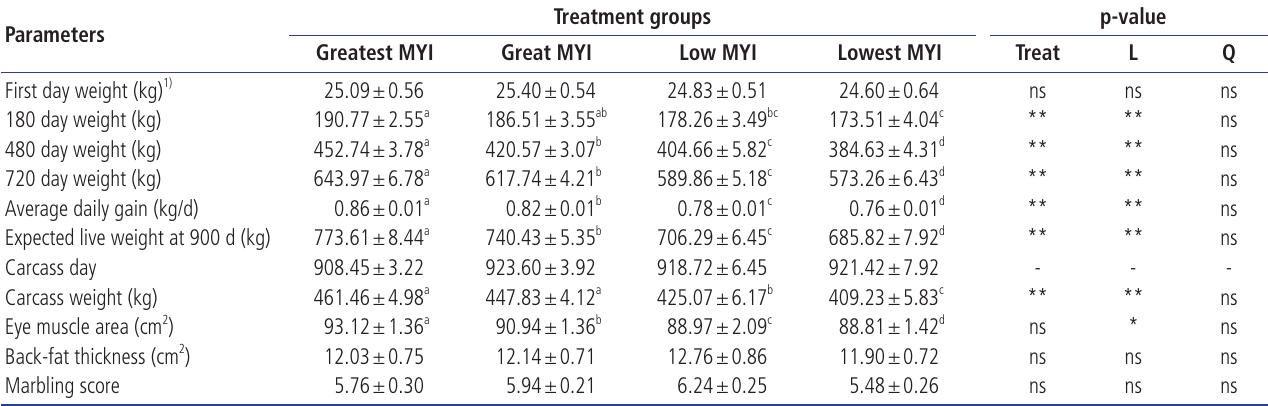
SE, standard error; MYI, meat yield index; Treat, treatment effect; L, linear effect; Q, quadratic effect. 1) First day or birth weight (kg) was received from the farm records and considered as initial body weight for the analysis. a-d Means in the same row with different superscript letters differ significantly (p<0.05).